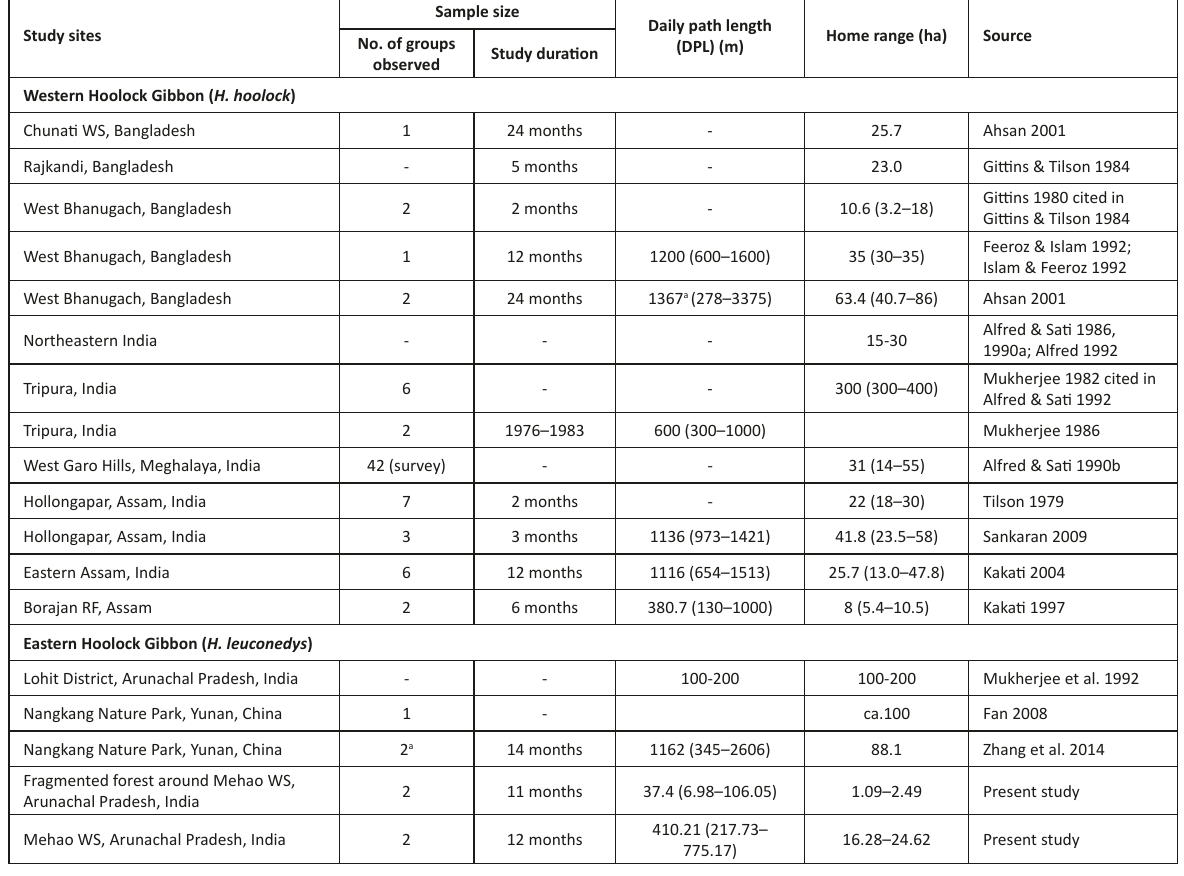
Table 5. Summary of information on Hoolock Gibbon daily path length and home range size. Numbers indicate mean values (and range of values). Also cited in Geissmann et al.